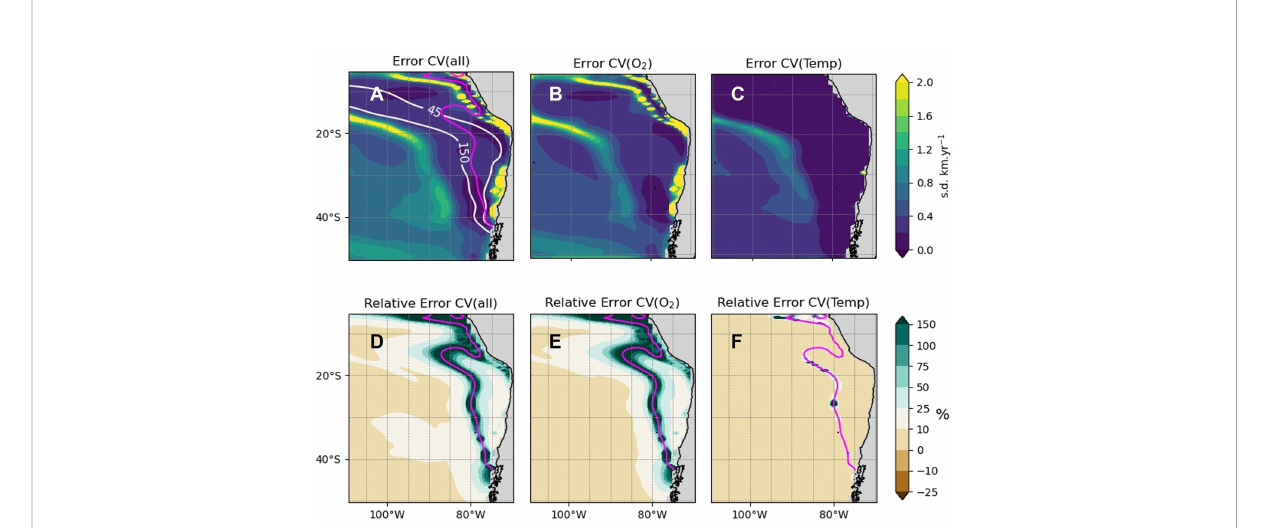
FIGURE 7 Uncertainty of CV F associated to natural variability at 200m. Error_CV F _all, Error_CV F _O 2 and Error_CV F _T correspond to the uncertainty associated to natural variability and the oxygen-trend and temperature-trend induced uncertainty, respectively. (A – C) provide the absolute error and (D – F) the relative error (%, see method section 2.4.2). The white contours are where [O 2 ] = 45 and 150 mmol.m -3 . The magenta dashed contours indicate the transition area (|CV F model |= 0 km.yr -1